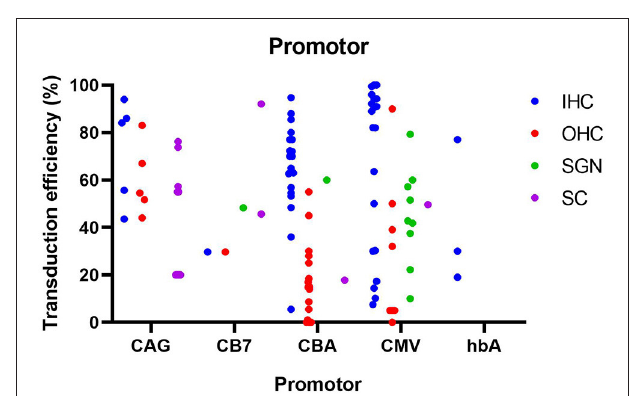
FIGURE 8 | Transduction efficiency of IHC, OHC, SGN and SC according to promoter type in mice. Only data from studies that performed inner ear application of AAV in mice were used to plot this graph. IHC, inner hair cell; OHC, outer hair cell; SGN, spiral ganglion neuron; SC, supporting cell in organ of Corti; CMV, cytomegalovirus; CAG, hybrid promoter; CB7, hybrid promoter; CBA, chicken β -actin; hbA, human β -actin.